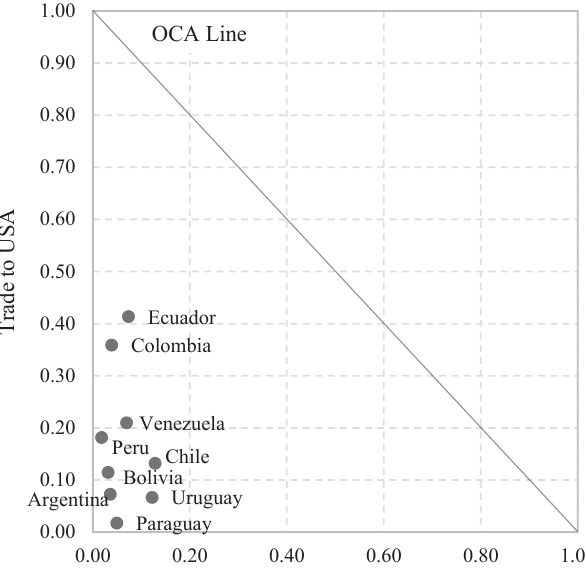
Figure 8. Costs and benefits